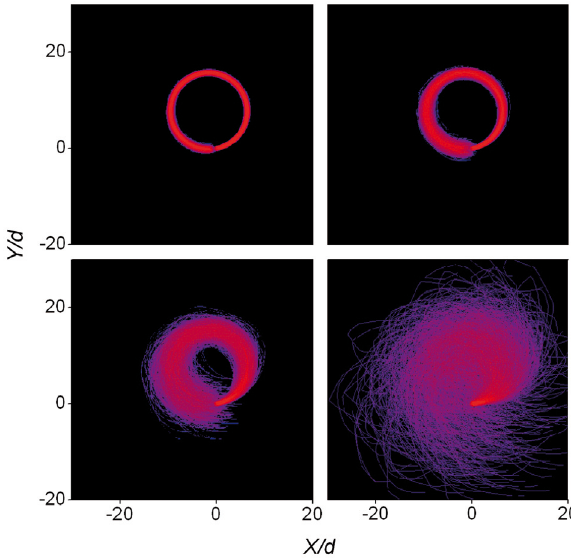
Figure 14 Each graph represents an ensemble of 10 4 simulated microbending experiments illustrating the probabilistic spectrum of possible outcomes for different thickness of the bending beams. Top left, d = 100 μm; top right, d = 10 μm; bottom left, d = 1 μm; bottom right, d = 0.1 μm; in the simulations, one end of the beams is clamped horizontally in the origin while a monotonically increasing torque is applied to the other